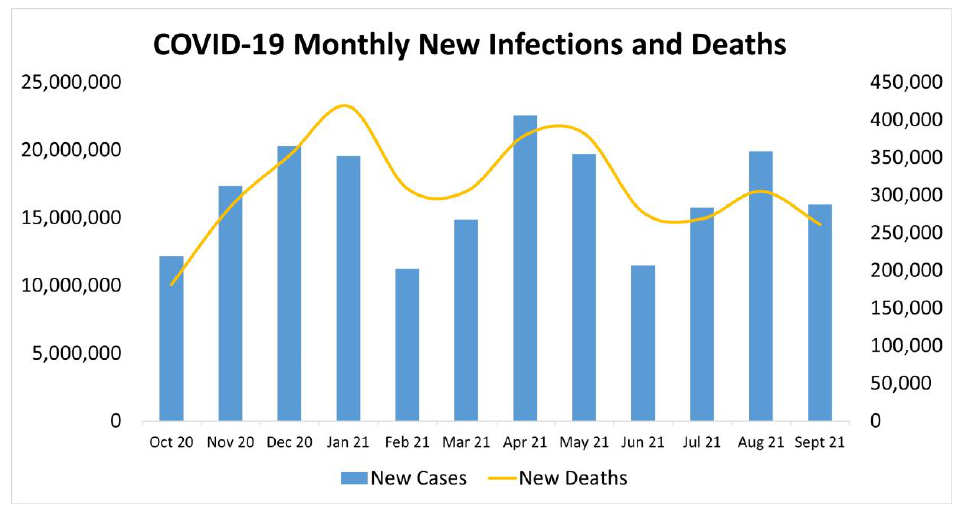
Figure 1. COVID-19 monthly new infections and deaths. Graphic presentation of monthly new infections of COVID-19 and monthly new deaths from October 2020 to September 2021. Table 1. Combined Datasets 1 and 2. Descriptive summary analysis of COVID-19 global statistics— Datasets 1 and